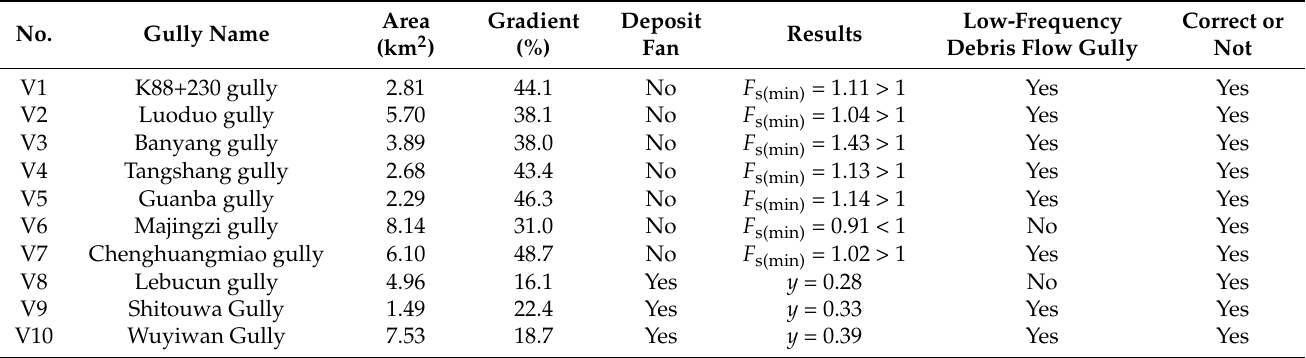
Table 5. The identification table of other low-frequency debris flows along the